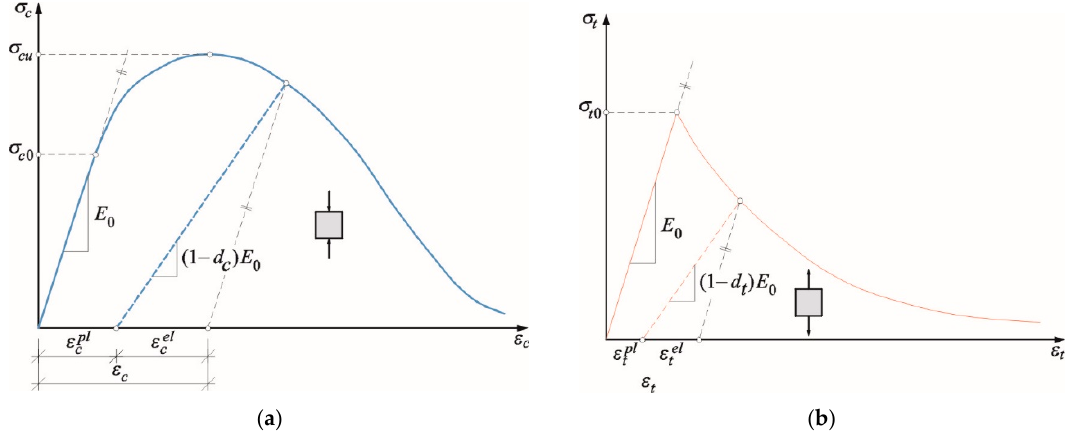
Figure 7. Mechanical constitutive law for the CDP model in: ( a ) compression; ( b ) tension [43].